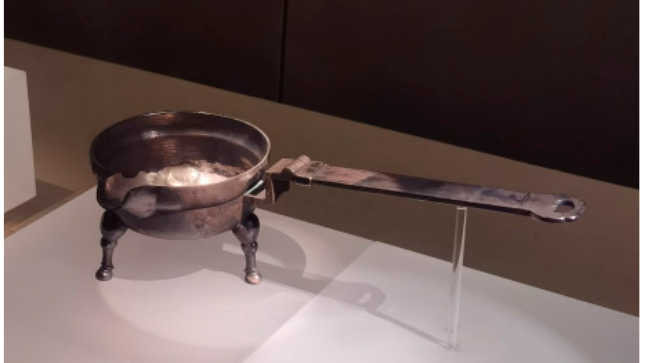
Figure 1. A silver pan ( cheng 鐺 ) of the Hejiacun Tang treasures. Photographed by the author.